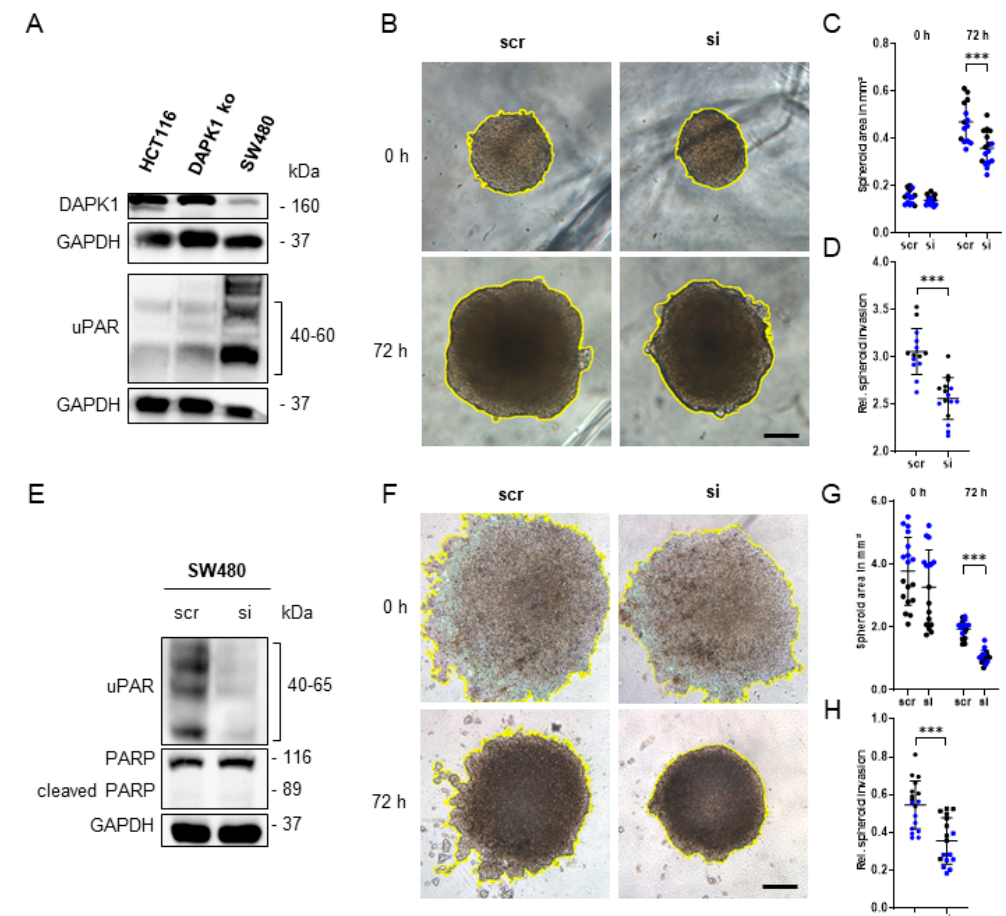
Figure 5. uPAR-dependent tumor cell invasion in vitro. ( A ) Western blot analysis of DAPK1 (lower band at 160 kDa) and uPAR expression in HCT116 WT, DAPK1 ko, and SW480 cells. In contrast to HCT116 WT cells, DAPK1 ko and SW480 cells show the same expression pattern (DAPK1 low, uPAR high) (original Western blot images presented in Figure S5B). ( B ) 3D-tumor spheroid-based invasion assay with uPAR siRNA/scrRNA-treated HCT116 DAPK1 ko cells. ( C ) Area quantification of uPAR siRNA/scrRNA-treated HCT116 DAPK1 ko 3D-tumor spheroids after embedding in Matrigel (0 h) and after 72 h in mm 2 (n samples = 16; 2-way ANOVA: *** p < 0.001). ( D ) The 3D-tumor spheroid invasion of uPAR siRNA/scrRNA-treated HCT116 DAPK1 ko cells after 72 h relative to time point 0 h (n samples = 16; Whitney test: *** p < 0.001). ( E ) Western blot of SW480 cells after siRNA and scrRNA transfection, demonstrating the successful knockdown of uPAR without inducing cell death (original Western blot images presented in Figure S5C). ( F ) A 3D-tumor spheroid-based invasion assay with uPAR siRNA/scrRNA-treated SW480 cells. ( G ) Area quantification of uPAR siRNA/scrRNA-treated HCT116 DAPK1 ko 3D-tumor spheroids after embedding in Matrigel (0 h) and after 72 h in mm 2 (scr: n samples = 18; si: n samples = 17; 2-way ANOVA: *** p < 0.001). ( H ) The 3D-tumor spheroid invasion of uPAR siRNA/scrRNA-treated SW480 cells after 72 h relative to time point 0h (scr: n samples = 18; si: n samples = 17; Whitney test: *** p < 0.001). Black dots in graphs represent the first biological replicate and blue dots represent the second biological replicate. Data represented as means ± SD.